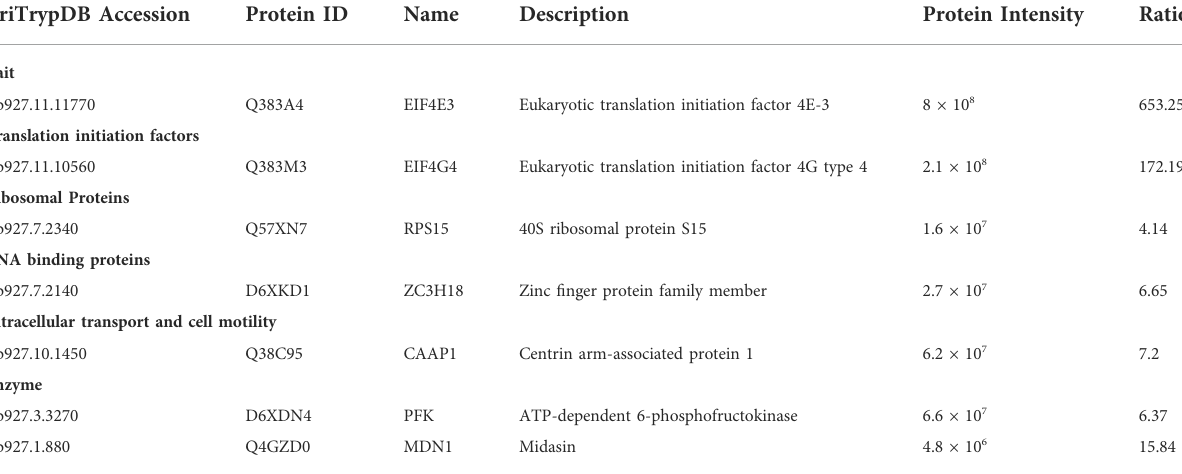
The table lists proteins co-immunoprecipitated with eYFP-EIF4E3 with an enrichment ratio > 4 in comparison to the negative control, eYFP-DRBD4, and classi fi ed according to selected functional categories (de fi ned in bold). The ratio column represents the average enrichment ratios.